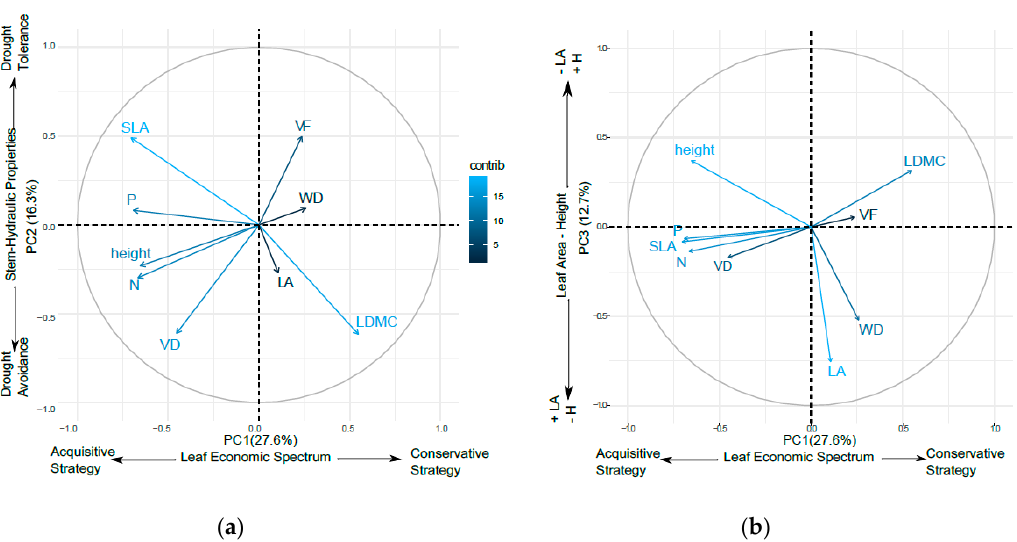
Figure 1. Principal components analysis (PCA) for the 9 leaf and stem for 21 oak species along the first three principal components (PC). ( a ) PC 1 and PC 2 ; ( b ) PC 1 and PC 3 . Colors indicate the contribution of each trait along the axes. LA (leaf area), SLA (specific leaf area), LDMC (leaf dry matter content), N (nitrogen concentration), P (phosphorus concentration), VF (vessel frequency), VD (vessel diameter), WD (wood density).